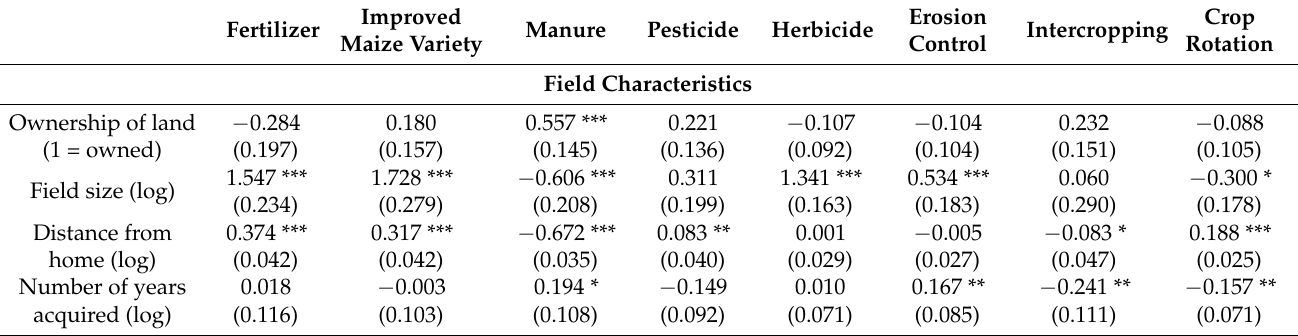
Table 5. Multivariate probit estimates of individual management